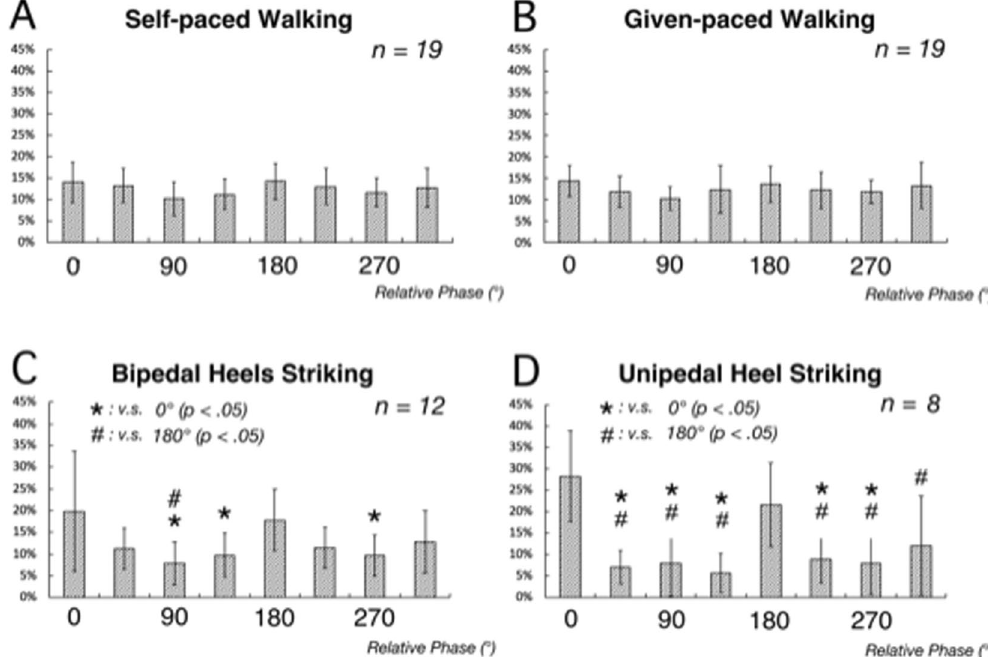
Figure 3. Normalized distribution of the relative phase of the group of subjects after exclusion of those subjects whose performance stability (CV) of finger tapping or walking was greater than 15%. ( A ) Self-paced walking task. ( B ) Given-paced walking task. ( C ) Bipedal heel striking task. ( D ) Unipedal heel striking task. Bars are s.d. * and # indicate significant differences from the bars centering on 0° and 180°,